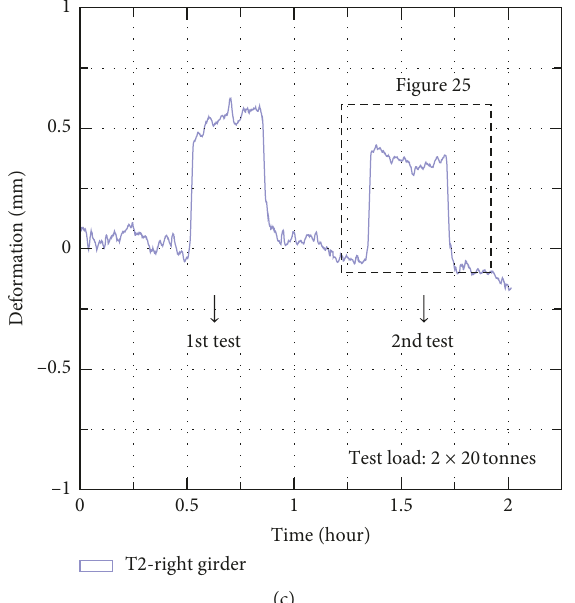
Figure 22: Graphs of the right girder (see sensor T2 in Figure 20) deflections (a) before strengthening (static load test with two load cases—heavy vehicles), (b) during prestressing, and (c) after strengthening (static load test with an identical load before